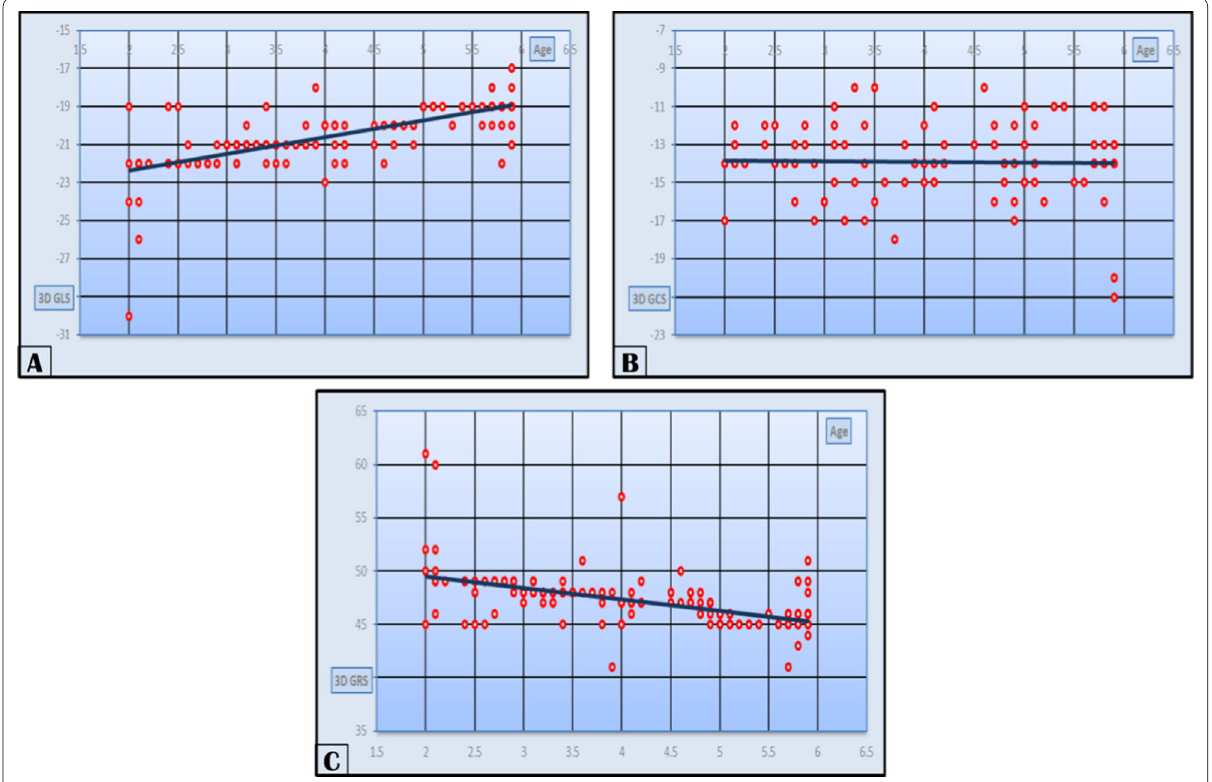
Fig. 4 Our study population 3D STE A GLS STE in relation to age, B GCS STE in relation to age, C GRS STE in relation to age